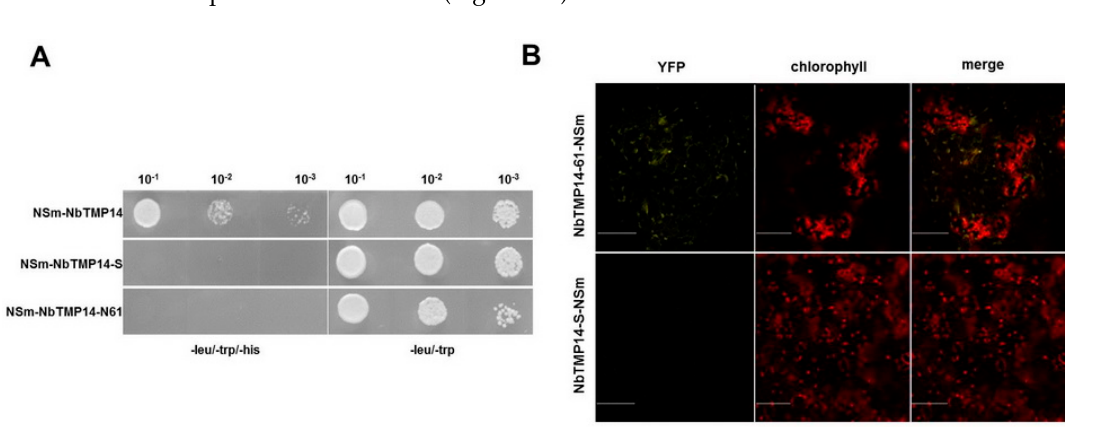
Figure 4. Transmission electron micrographs of N. benthamiana cells. The chloroplasts of TSWV-infected plants were abnormal and had larger starch granules. In the NbTMP14 knock-down plants, most chloroplasts were broken, and starch granules were enlarged. Scale bars represent 2 μ m.